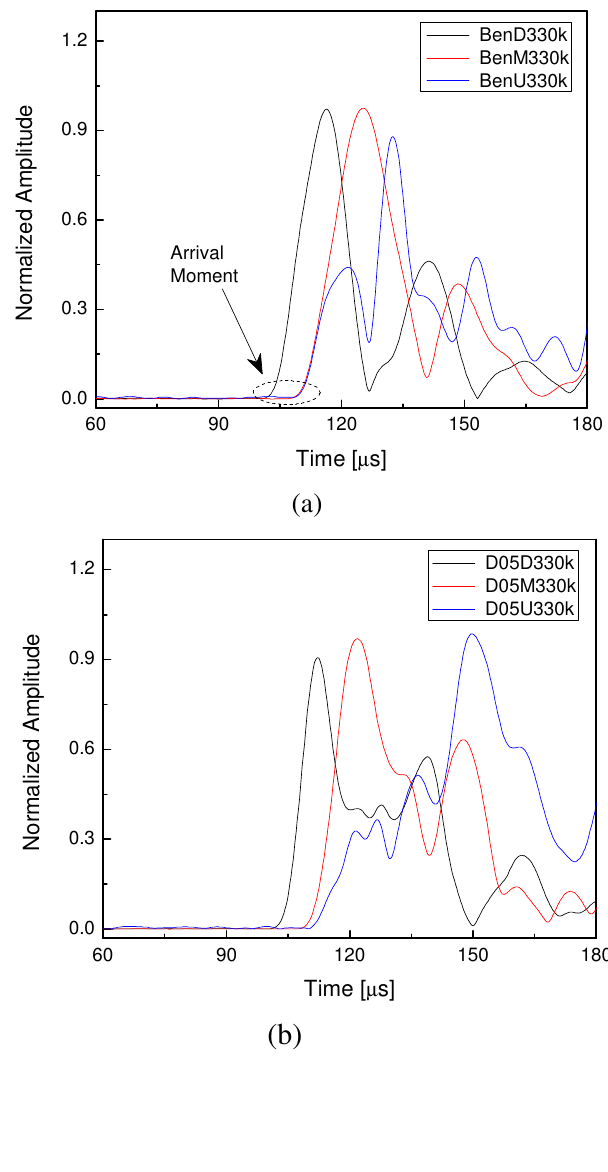
Figure 8. Normalized envelopes of guided wave signals captured using FOD sensors from (a) intact CFRP specimen and defected CFRP specimens with the debonding